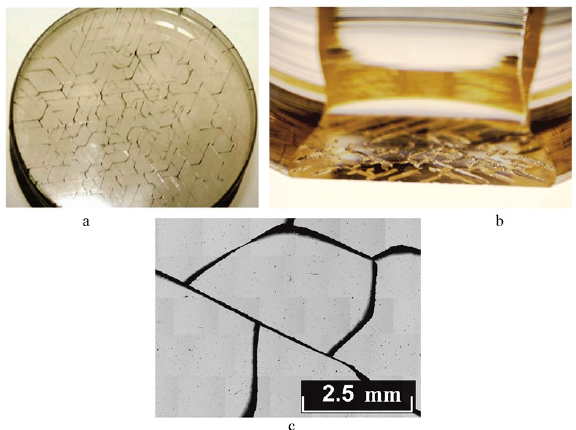
Figure A7. ( a )–precipitation of the second phase with semi-coherent boundaries in the LiNbO 3 :Zn crystal (direct doping, [Zn] = 4.68 mol% in the crystal) Z-cut, after the high-temperature electrodiffusion annealing; ( b )–separation of the second phase with partially coherent boundaries in the LiNbO 3 :Zn crystal ([ZnO] = 5.84 mol% in the melt), Z-cut.